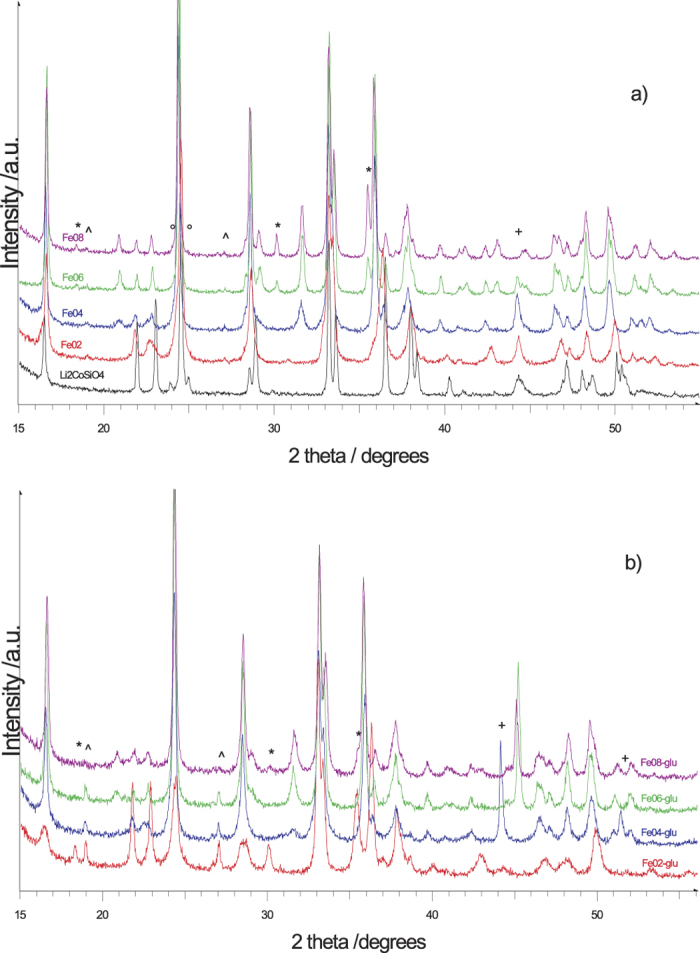
Comparison between XRPD patterns of the samples (a) without and (b) with glucose addition. The symbols mark the main peaks of magnetite (*), Li2SiO3 (^), Li2Si2O5 (°) and Co(+).